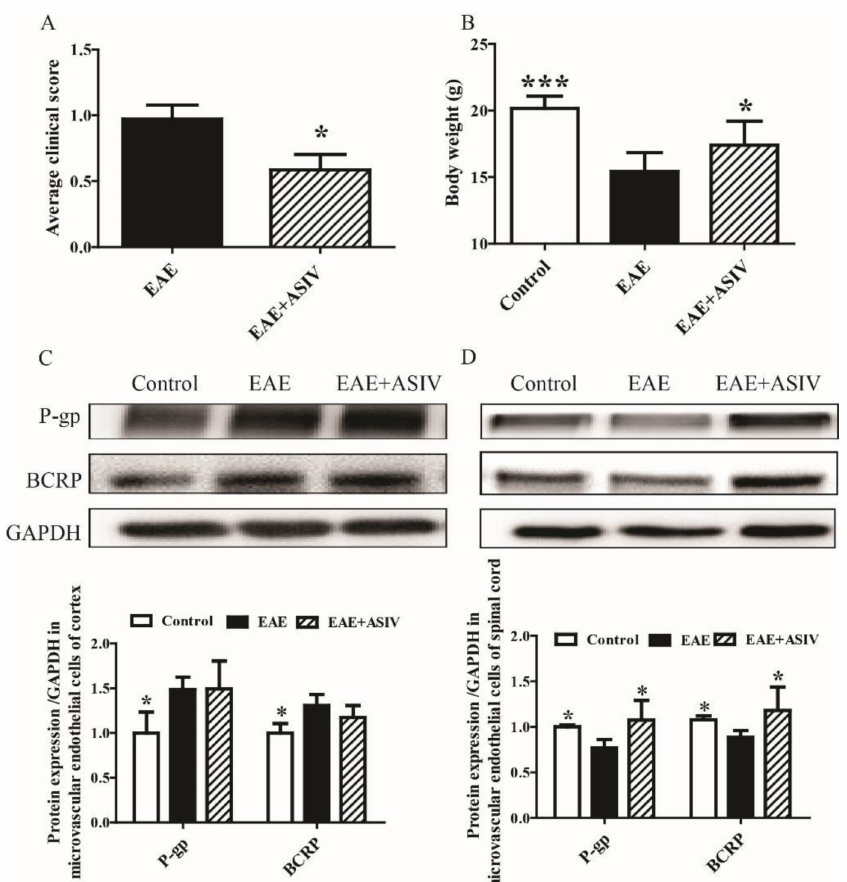
Figure 1. Effect of astragaloside IV (ASIV) on the expression of ATP-binding cassette (ABC) transporters in experimental autoimmune encephalomyelitis (EAE) mice. ( A ) Clinical scores of EAE mice; ( B ) body weight loss of EAE mice; ( C ) protein expression of P-glycoprotein (P-gp) and breast cancer resistance protein (BCRP) in microvascular endothelial cells isolated from cortex of EAE mouse ( n = 5); ( D ) protein expression of P-gp and BCRP in microvascular endothelial cells isolated from spinal cord of EAE mouse ( n = 5). Values are expressed as mean ± SD. Data were analyzed by one-way analysis of variance with Dunnett’s multiple comparison test or unpaired t -test. * p < 0.05, *** p < 0.001 vs. EAE